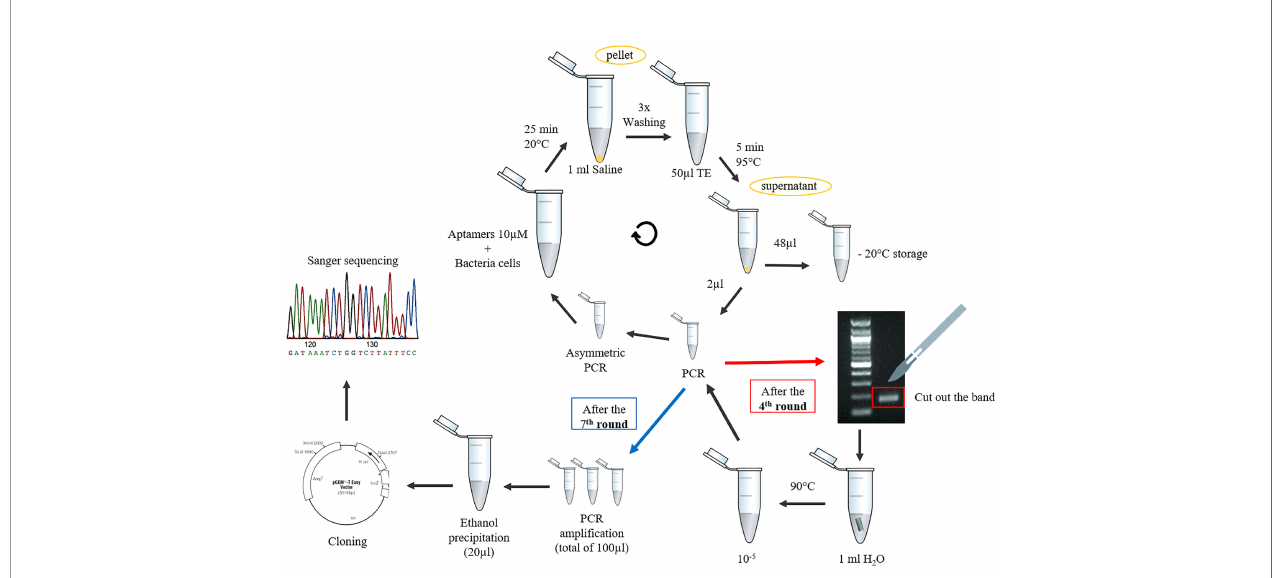
FIGURE 1 | Steps of the Cell-SELEX protocol proposed in this